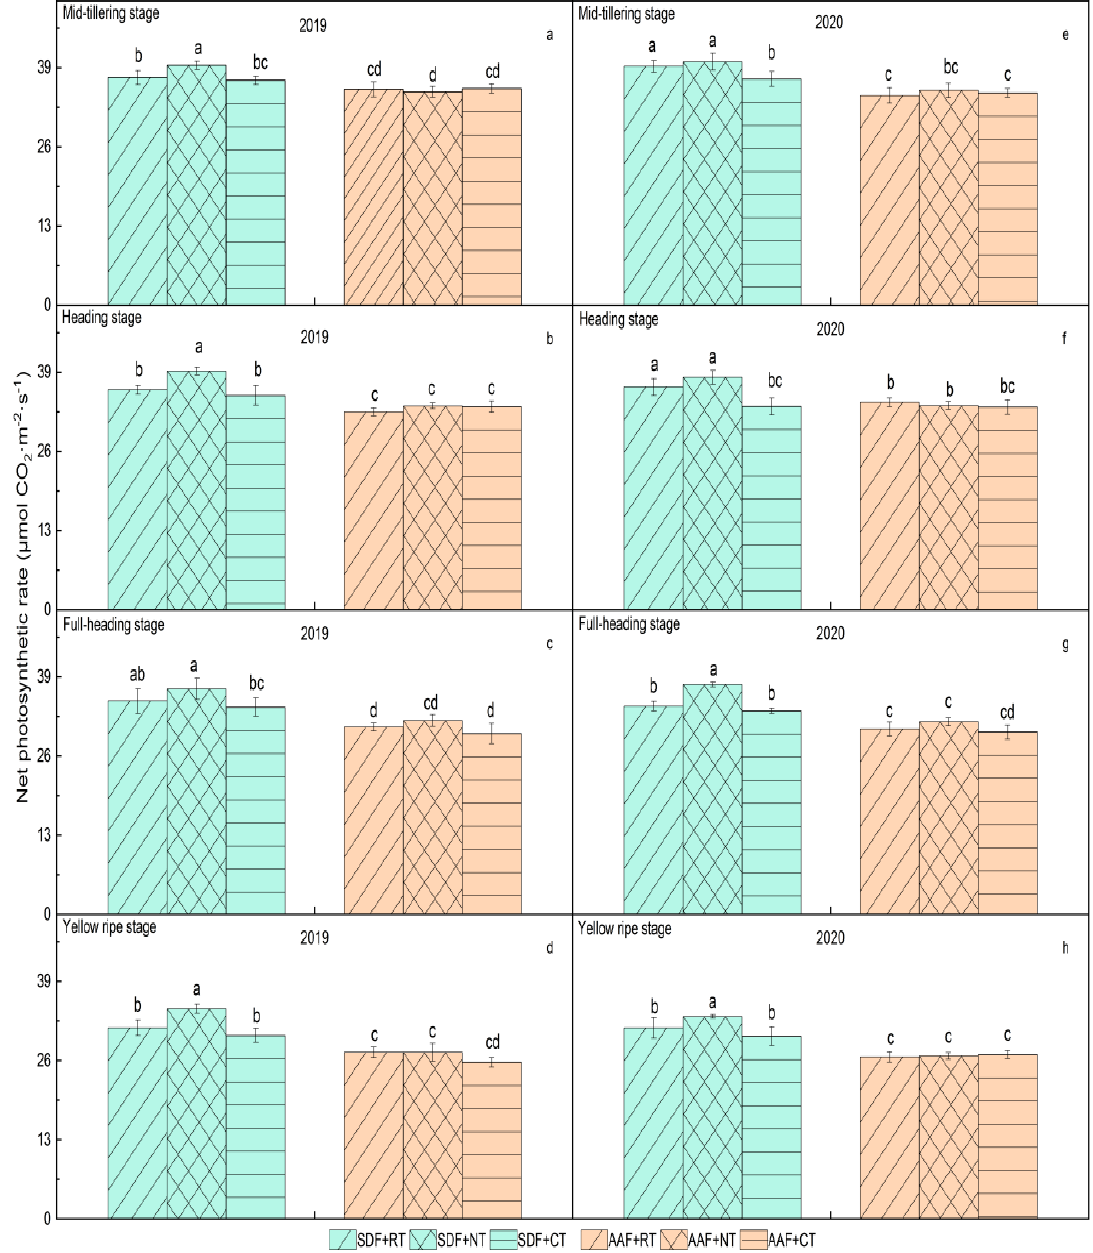
Figure 5. Net photosynthetic rate at different stages of rice under different tillage and fertilization treatments. ( a – d ) represent the net photosynthetic rate in mid-tillering stage, heading stage, full-heading stage, and yellow ripe stage in 2019, respectively. ( e – h ) represent the net photosynthetic rate in mid-tillering stage, heading stage, full-heading stage, and yellow ripe stage in 2020, respectively. Different lowercase letters marked on the histogram mean significant differences among treatments at the 5% level according to Duncan’s multiple-range test (0.05) (similarly hereinafter).